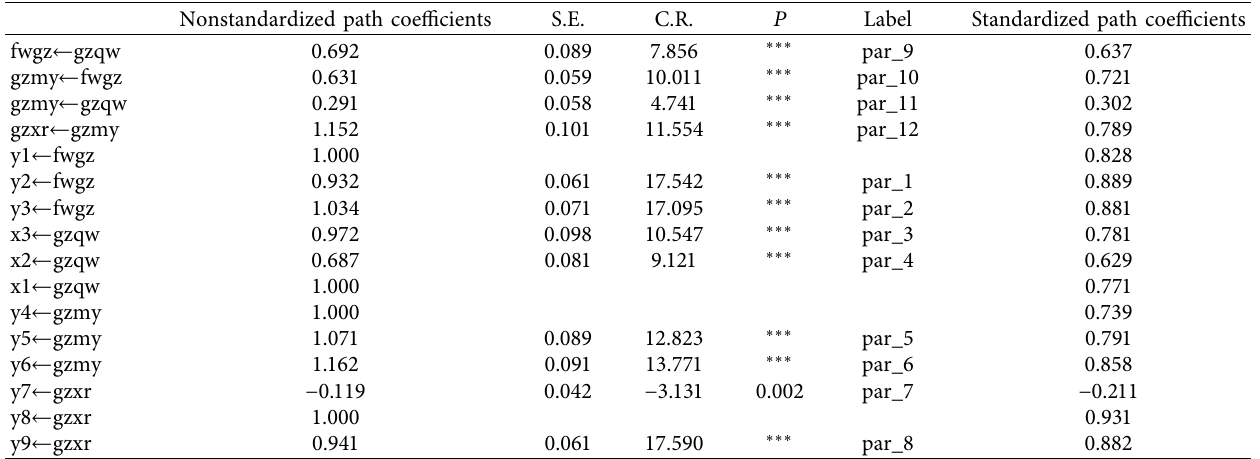
Table 9: Final estimates of path